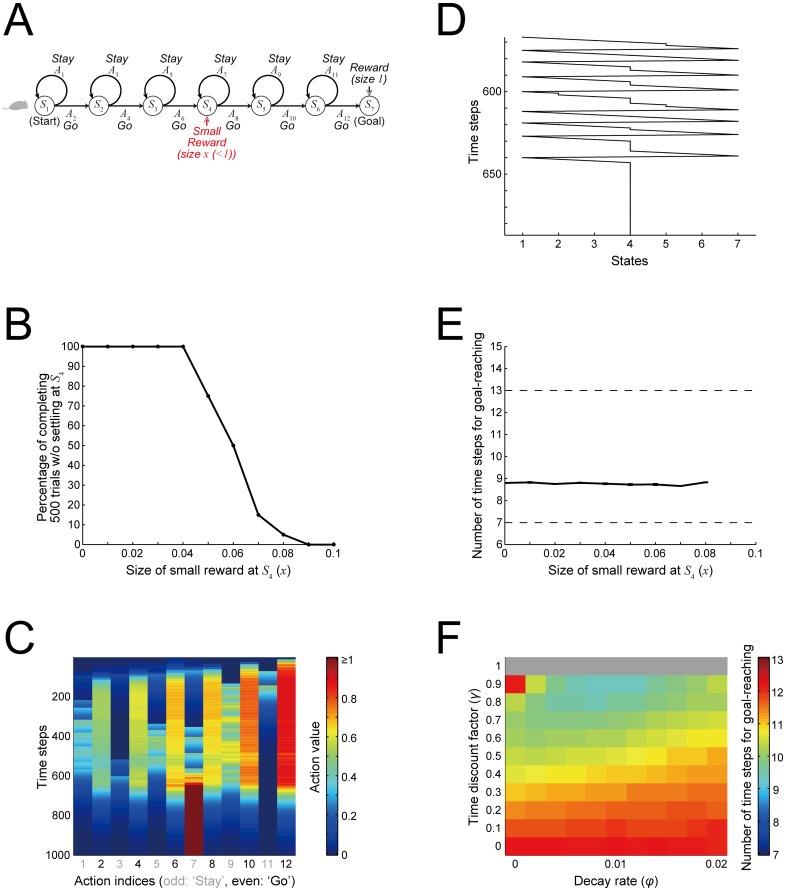
Robustness of the effect of the value-decay to perturbations in reward environments.(A) Simulated perturbation: small reward of size x (< 1, which is the amount of the reward given at the goal) is given at S4 whenever subject is located there (i.e., repeatedly at every time step if subject stays at S4). (B) Percentage of simulation runs (out of total 20 runs for each condition) in which subject completed 500 trials within 35000 time steps (i.e., within 70 time steps per trial on average) without settling at S4. (C) Time evolution of the action values in a simulation run with x = 0.1 in which subject settled at S4 before completing 500 trials. The color indicates the action value in reference to the rightmost color scale bar: note that the color is saturated for values ≥ 1. The vertical axis indicates the time steps (from top to bottom) and the horizontal axis indicates the indices of the actions (odd/gray: ‘Stay’, even/black: ‘Go’: Fig 13A). At around time-step 650, the value of A7 (i.e., ‘Stay’ at S4) became very large while the values of the other actions decayed out, indicating that subject settled at S4. (D) The subject's state transitions in the simulation run shown in (C) around time-step 650, showing that the subject indeed settled at S4 around this time. (E) Number of time steps needed for goal-reaching averaged over 500 trials. The solid line with error bars indicates the mean ± SE for the simulation runs in which 500 trials were completed. The two dashed lines indicate the theoretical minimum (bottom) and the chance level (top). (F) Simulation results with x = 0.1 for the cases with both the value-decay (horizontal axis) and temporal discounting (vertical axis). The color indicates the number of time steps needed for goal-reaching averaged over 500 trials, further averaged over 20 simulations, in reference to the rightmost color scale bar: the gray zone at the top (γ = 1) indicates that, in these conditions (i.e., without temporal discounting), subject did not complete 500 trials.